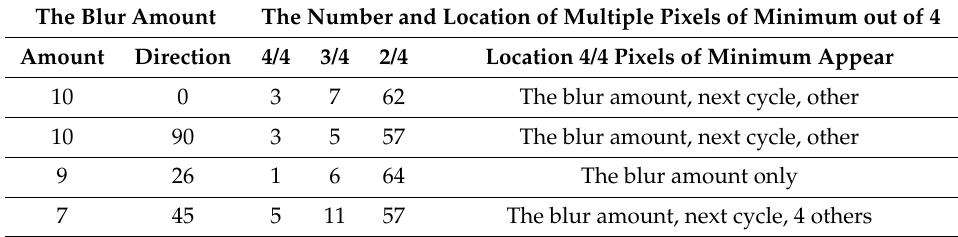
Table 9. The number of the pixels and their locations where multiple pixels of minimum appeared out of four sub-images out of area A The Blur